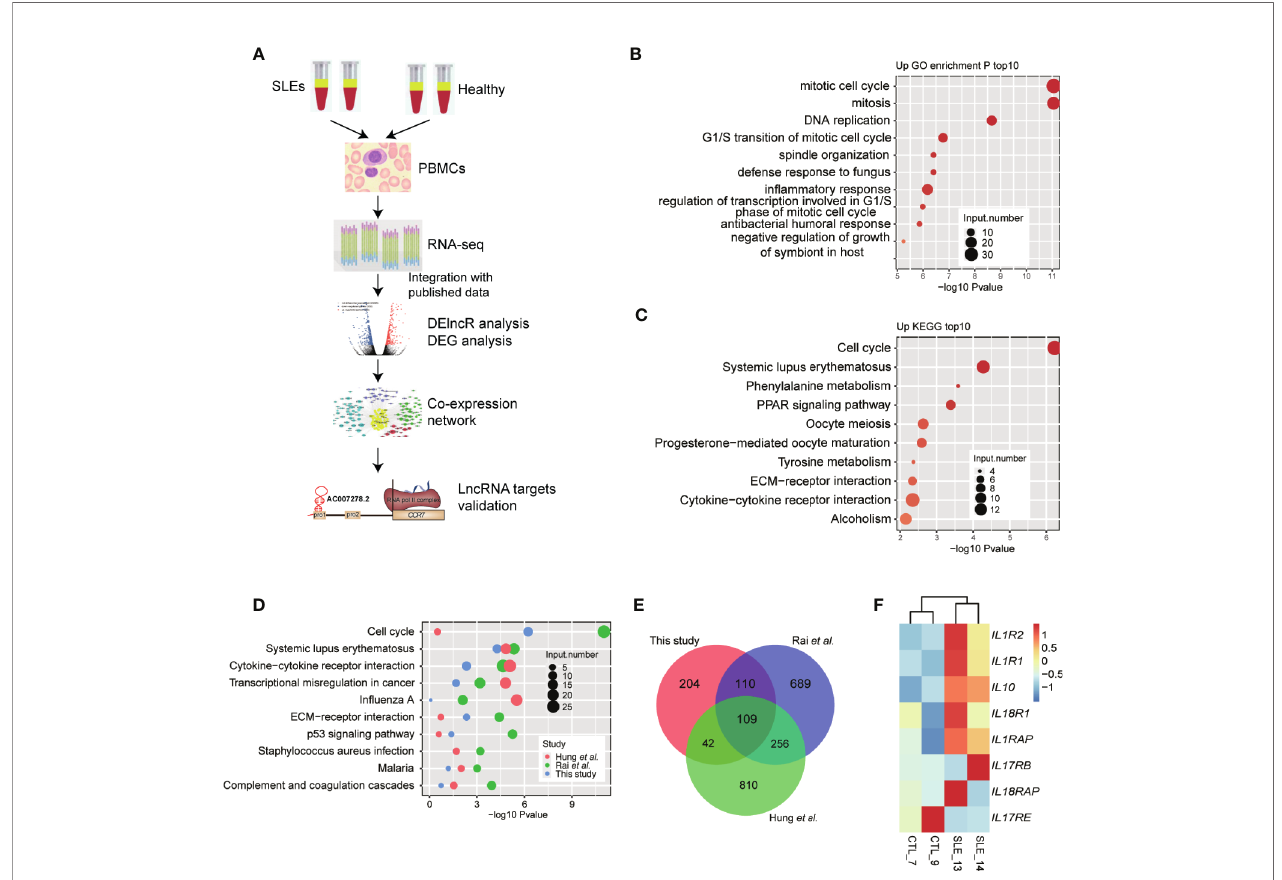
FIGURE 1 | RNA-seq results show the aberrant protein-coding gene expression levels in systemic lupus erythematosus (SLE) peripheral blood mononuclear cell samples. (A) Work fl ow shows the experimental strategies and analyses in this study. (B) Bar plot shows the top 10 enriched Kyoto Encyclopedia of Genes and Genomes (KEGG) pathways of genes down-regulated in SLE patients. (C) Bar plot shows the top 10 enriched KEGG pathways of genes up-regulated in SLE patients. (D) Bubble plot shows the top enriched KEGG pathways of differentially expressed genes from three published datasets. (E) Venn diagram shows the overlap of up-regulated genes in the three RNA-seq datasets. (F) Heat map shows the up-regulation of interleukins and their receptors in SLE